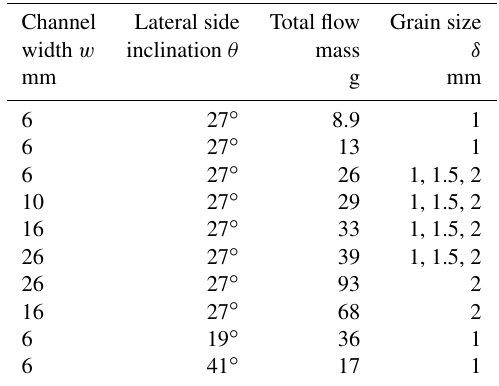
Figure 4. Shapes of the particles that are used in the numerical sim- ulations. The inscribed clusters of spheres are also shown. Table 1. Characteristics of channels and flows.